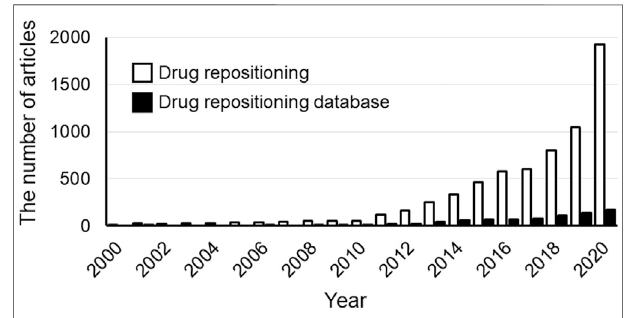
FIGURE 1 | The number of publications from 2000 to 2020. The white and black bars show the results of searches performed in Scopus on the “ Drug Repositioning ” or “ Drug Repositioning ” and “ databases ” , respectively. The number of drug-repositioning studies has increased with the increase in the number of databases. Date of analysis: Jul 9, 2021.